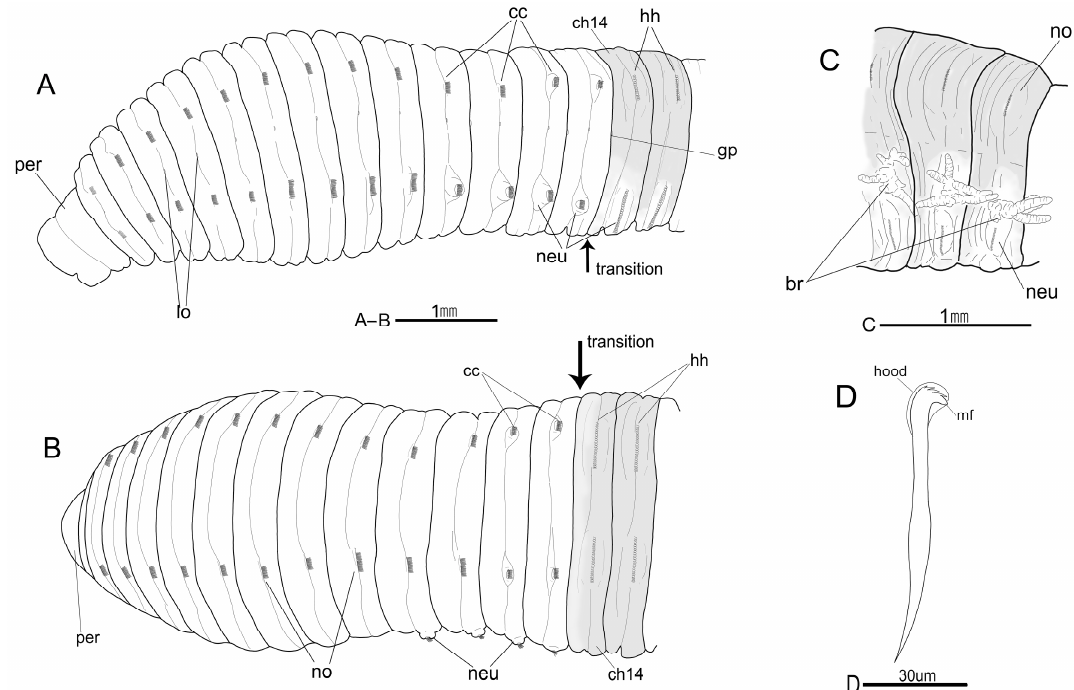
Figure 2. Dasybranchus geojedoensis sp. nov. (shadings indicate methyl green staining patterns (MGSP)). ( A ) Anterior end, left lateral view; ( B ) Same, dorsal view; ( C ) Abdominal chaetigers 64–66, left lateral view; ( D ) Abdominal hooded hook, lateral view. Br, branchiae; cc, capillary chaetae; ch, chaetiger; gp, genital pore; hh, hooded hooks; lo, lateral organ; mf, main fang; neu, neuropod; no, notopod; per, peristomium.